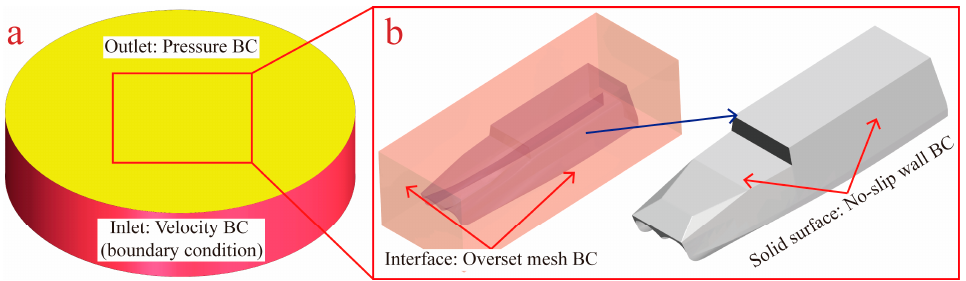
Figure 3. Computational domain: ( a ) background region, ( b ) overset region.